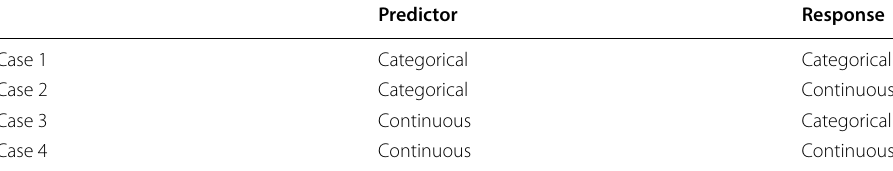
Table 1 Relevant cases for statistical measures of